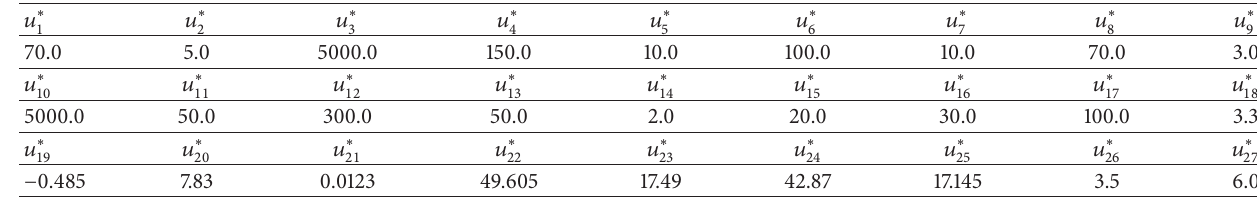
Table 2: The boundary of 𝑢 ∗ 𝑖